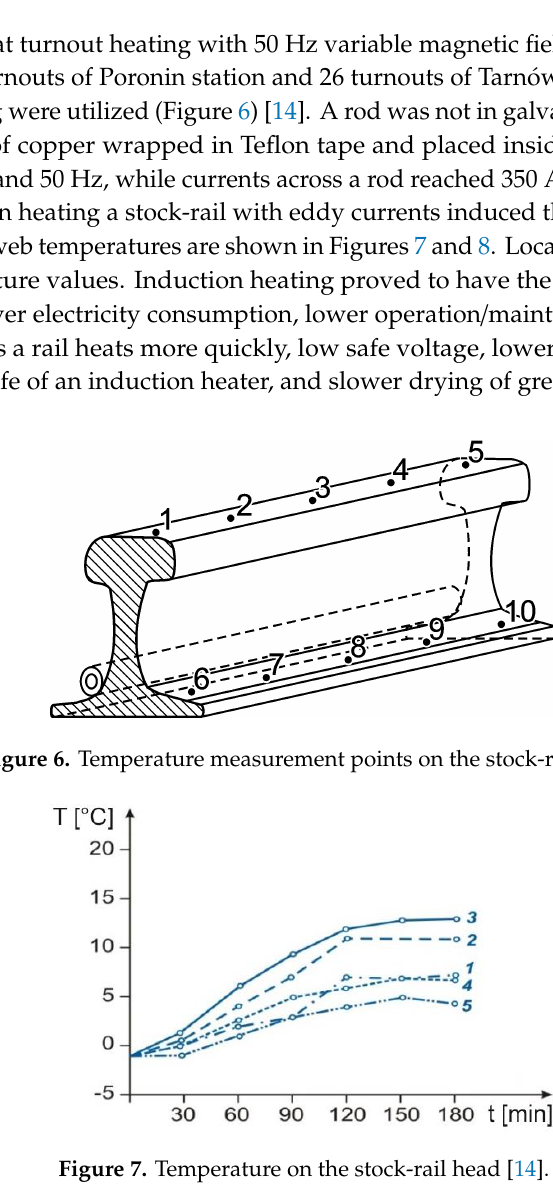
Figure 5. Cross-section of induction heating device; R — rail, HI — inductor, C — coil, F — inductor core, U — supply voltage, I — insulation [13].